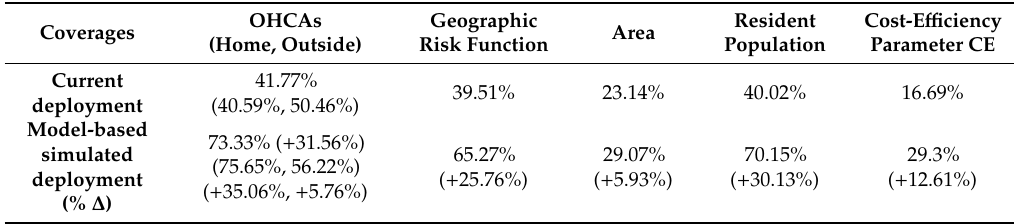
Table 2. Detailed results of performance analysis where a model-based distribution of the same number of Automated External Defibrillators (AEDs) that are currently deployed is